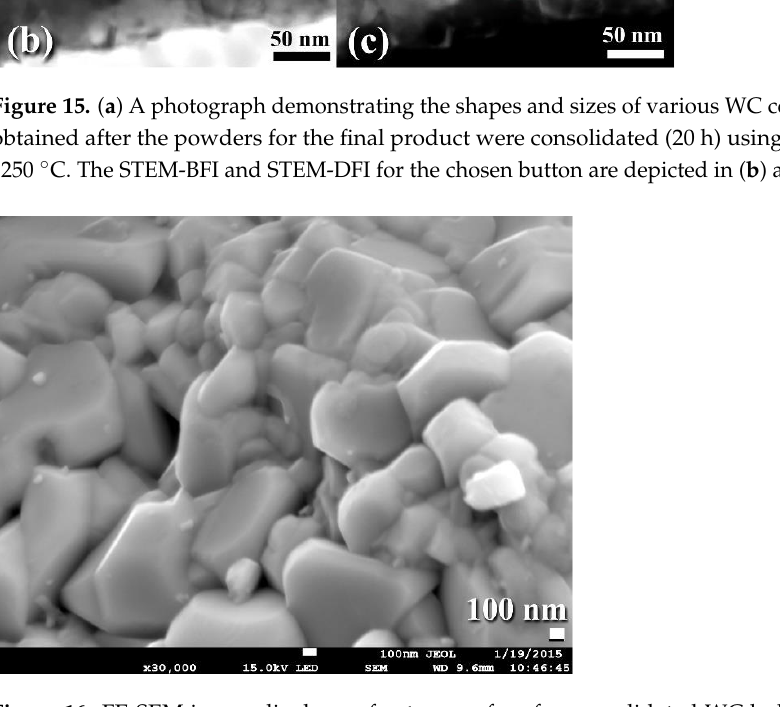
Figure 16. FE-SEM image displays a fracture surface for consolidated WC bulk sample obtained upon SPS the as milled powders for 20 h at 1250